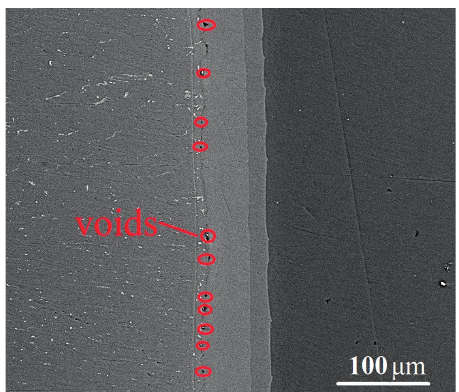
Figure 6: Voids at the Mg/Al joint interface obtained at 445°C for 90 min.